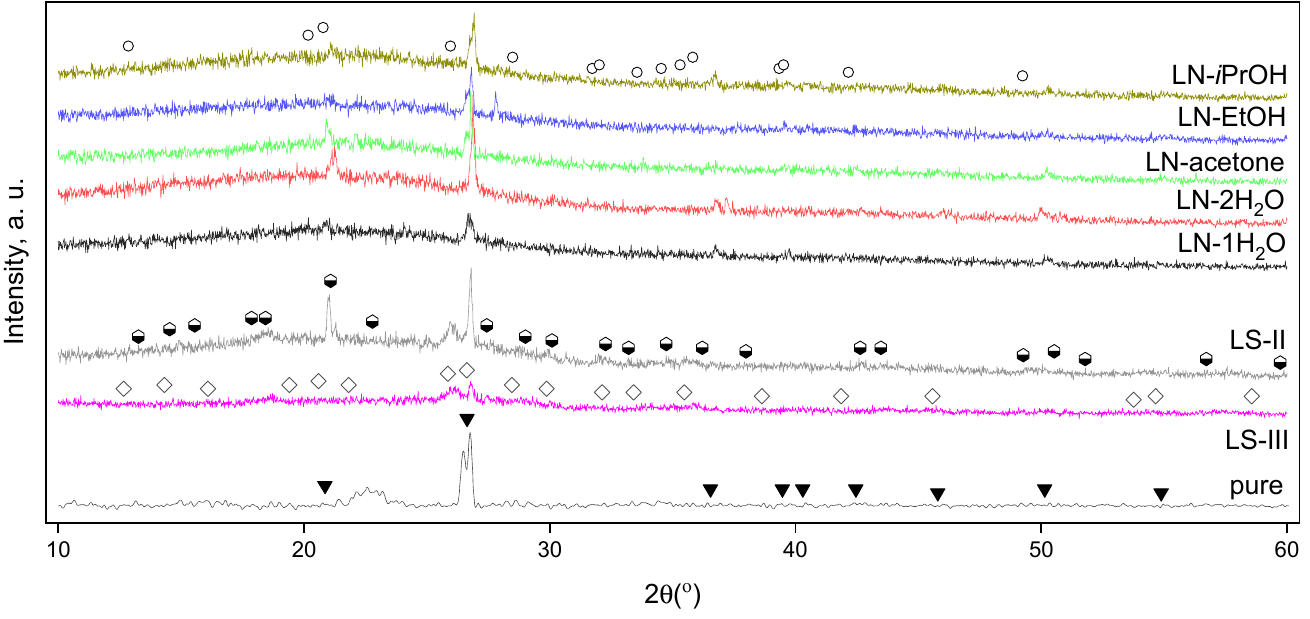
Figure 3. The diffractograms of the samples of hydrolytic lignin impregnated with different iron salts solutions and of the starting lignin. The ICDD patterns of quartz [46-1045] ( Β ), fibroferrite (iron(III) sulfate hydroxide pentahydrate) [38-0481] ( Μ ), xitieshanite (iron(III) sulfate hydroxide heptahydrate) [35-0719] ( ϖ ), iron(III) nitrate nonahydrate [01-0124] ( − ) are shown to indicate the locations of the possible phases reflexes.